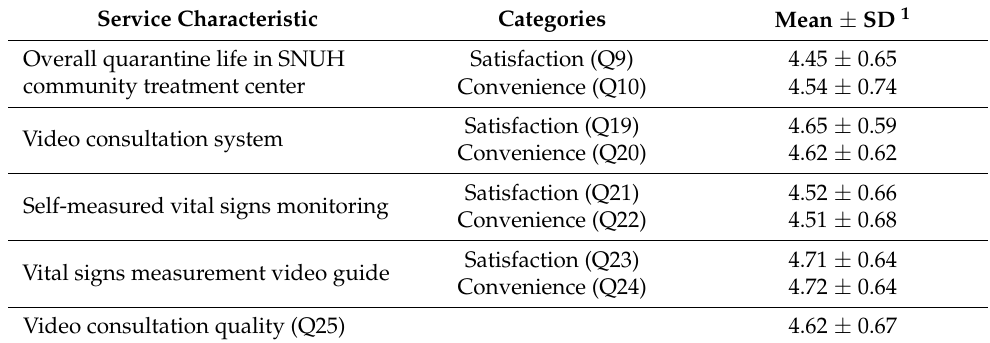
Table 3. Satisfaction in SNUH Community Treatment Center (SNUH-CTC) ( N =